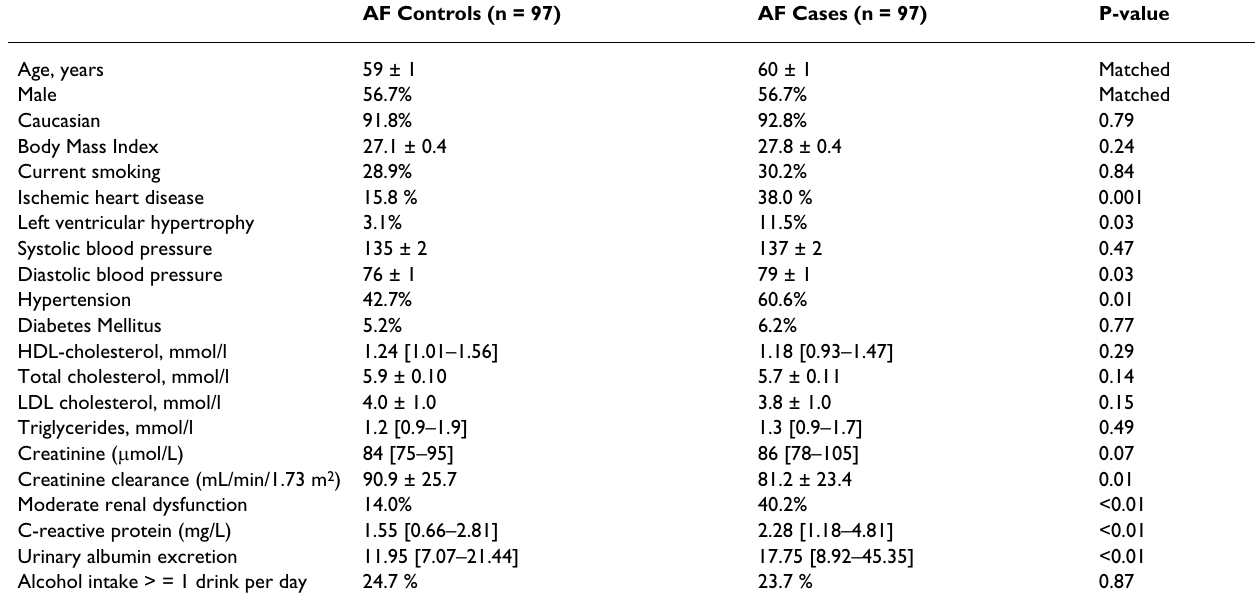
Table 1: Baseline characteristics of the nested case-control study divided by control group of subjects without atrial fibrillation (AF) and cases with AF. Data shown as percentages for categorical variables and mean ± standard deviation for continuous variables. HDL- cholesterol, Triglycerides, Creatinine, C-reactive protein, and urinary albumin excretion are expressed as median [interquartile